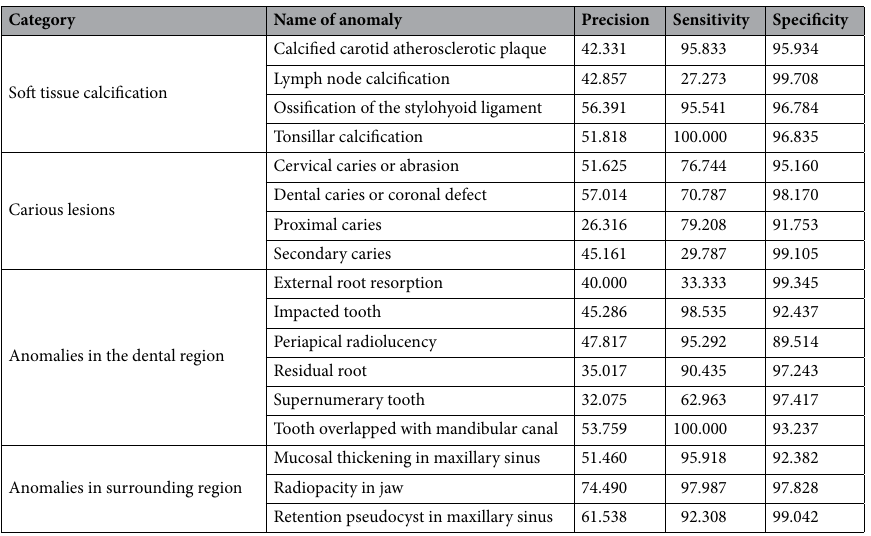
Table 2. Class-wise performance score of the trained model.